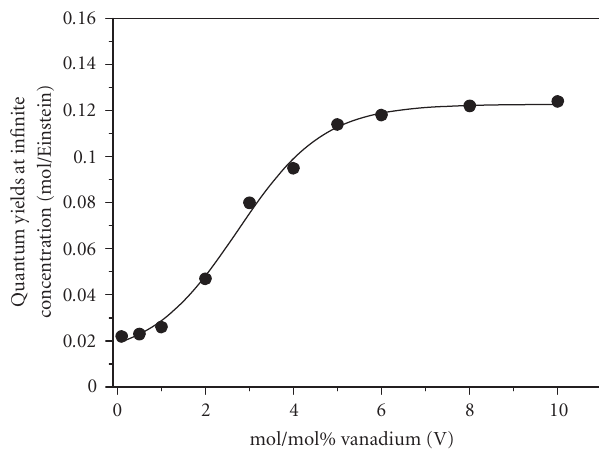
Figure 7: Quantum e ffi ciencies Φ ∞ (mol/Einstein) of methane, ex- trapolated by (17), at infinite concentration of substrate, relative to measurements carried out in the gaseous phase, as a function of absorbed power per unit length of irradiated photocatalytic mem- brane, expressed asW · cm − 1 . Photocatalytic membranes used in the relative experiments contained the photopromoter (see Experimen- tal) at a concentration corresponding to 3.0mol/mol % of vana- dium with respect to titanium present as main photocatalyst.